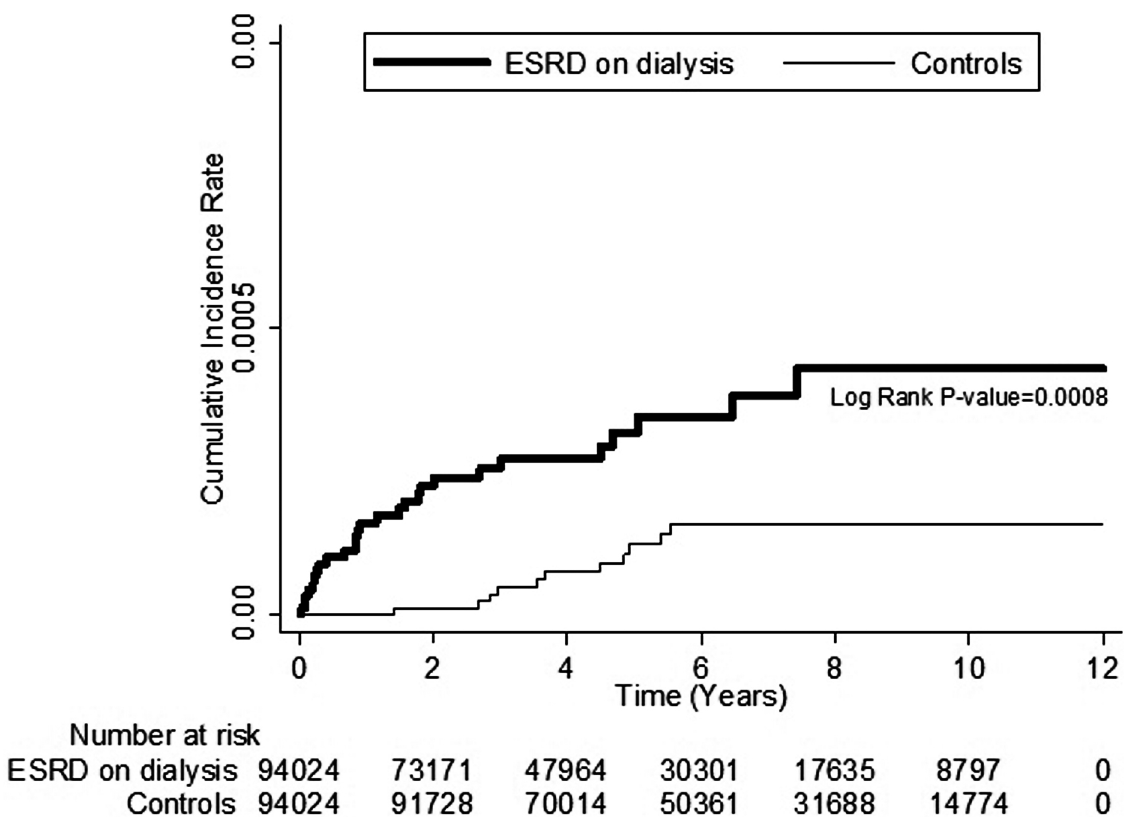
Fig 1. Kaplan–Meier curve of cumulative incidence of serous retina detachment in patients with end-stage renal disease (ESRD) and controls during the follow-up period.